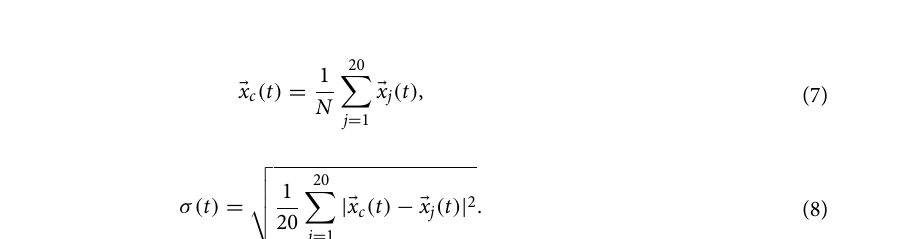
x at t is inside or outside the formation. We roughly regard (cid:31)